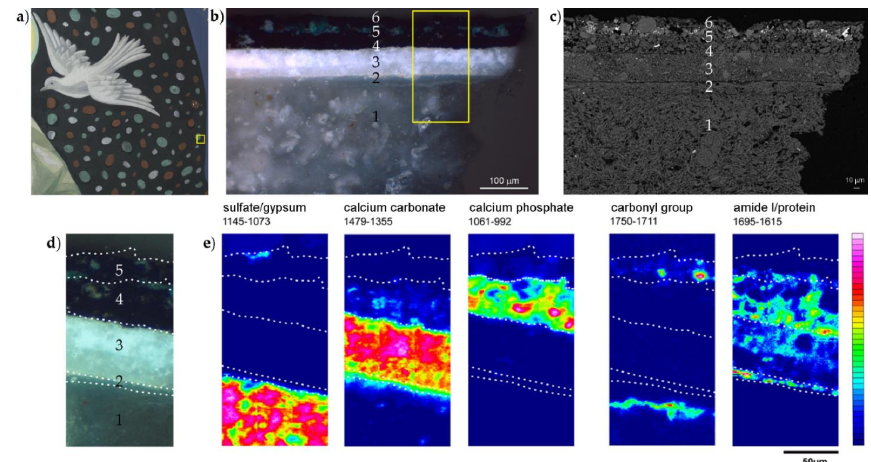
Figure 4. ( a ) Detail of the Trinity background (image size ca. 80 cm × 80 cm) with indication (yellow square) of the sampling area (black edge of a green dot); ( b ) optical microscope image and ( c ) SEM- BSE image of the cross-section of the micro-sample collected in a; ( d ) cross-section area analyzed by FTIR-FPA imaging (the location is shown in b with a yellow rectangle); ( e ) FTIR-FPA imaging results with integration of the following spectral range: 1145–1073 cm –1 (sulfate/gypsum), 1479–1355 cm